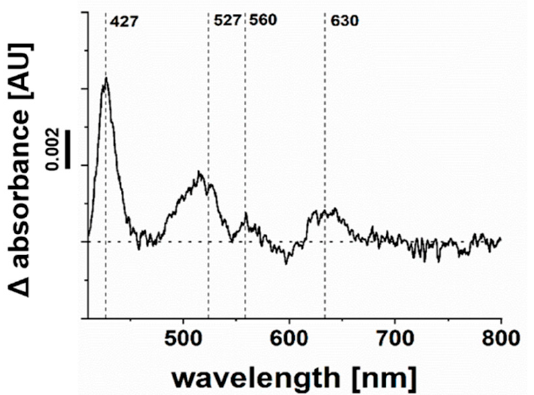
Figure 7. Detection of hemes b and d in solubilized membranes of P. bivia . VIS difference spectrum of dithionite-reduced minus air-oxidized DDM solubilisates (0.8 mg protein/mL) with the maxima of reduced heme b (560 nm, 527 nm, and 427 nm) and heme d (630 nm). A typical trace from three biological replicates is presented.